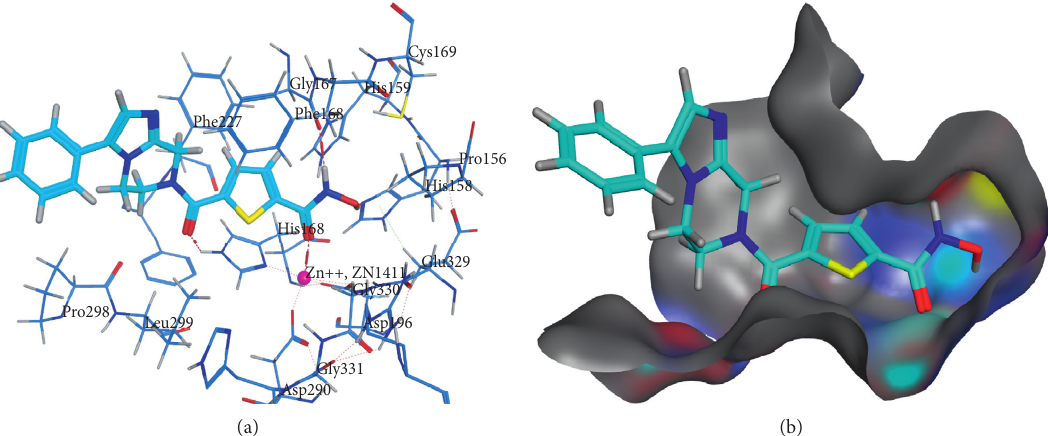
Figure 5: (a) 3D structure of the co-crystallized ligand docked into the active site of HDAC.(b) 3D structure of compound 1 docked into the active site of